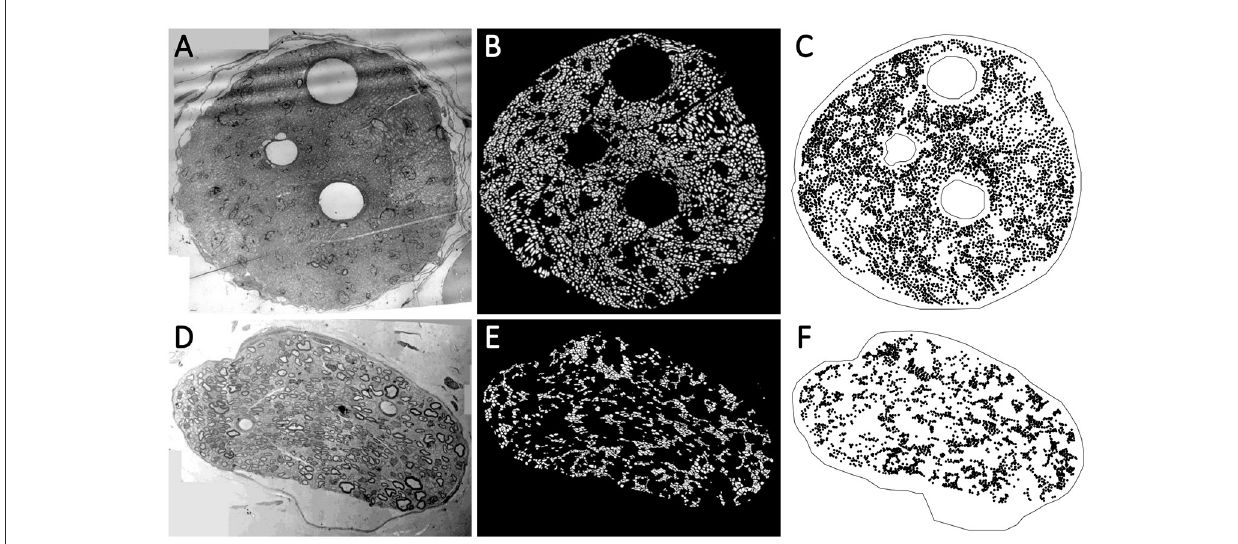
FIGURE2 (A, D) The transmission electron microscopy (TEM) images of the nerve cross-section of Image 15 (vagus) and Image 29 (pelvic) listed in Table 1, respectively. The visible void spaces in the nerve cross-sections are blood vessels. The tiny light gray regions without any border are the unmyelinated axons. The myelinated axons have slightly darker gray borders. (B, E) The automated segmentation of the unmyelinated axons (the white regions) in the nerve cross-sections. (C, F) The spatial point patterns constructed with the centroid locations (the black circles) of the segmented unmyelinated axons.